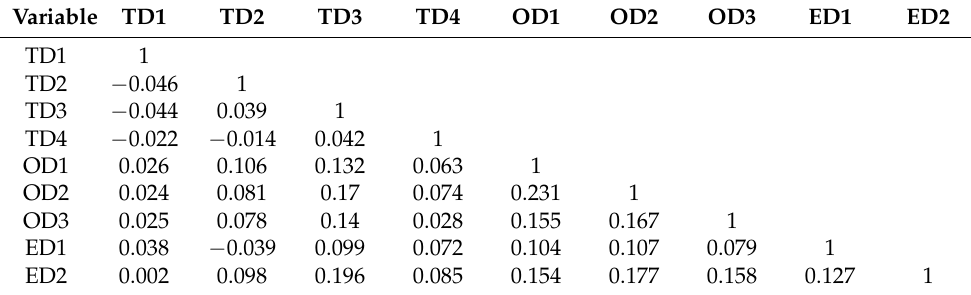
Table 3. Correlations between independent variables.